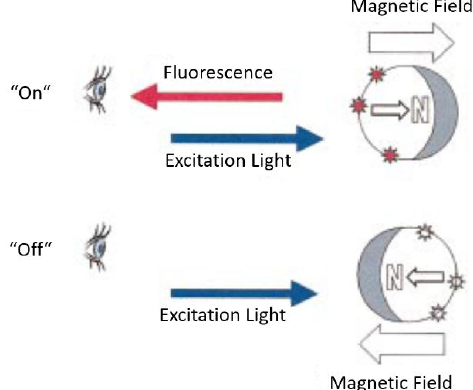
Figure 17. Sketch of modulated fluorescence by magnetic particles with a hemispherical metal coating (dark-shaded area). The coating prevents excitation/detection of fluorophores at the particle surface when the particle is rotated with the coated side towards the excitation source/observation optics by an applied magnetic field, resulting in magnetically controllable modulation of the observed fluorescence. Modified graph reprinted with permission from [218]. Copyright 2003, AIP Publishing LLC.